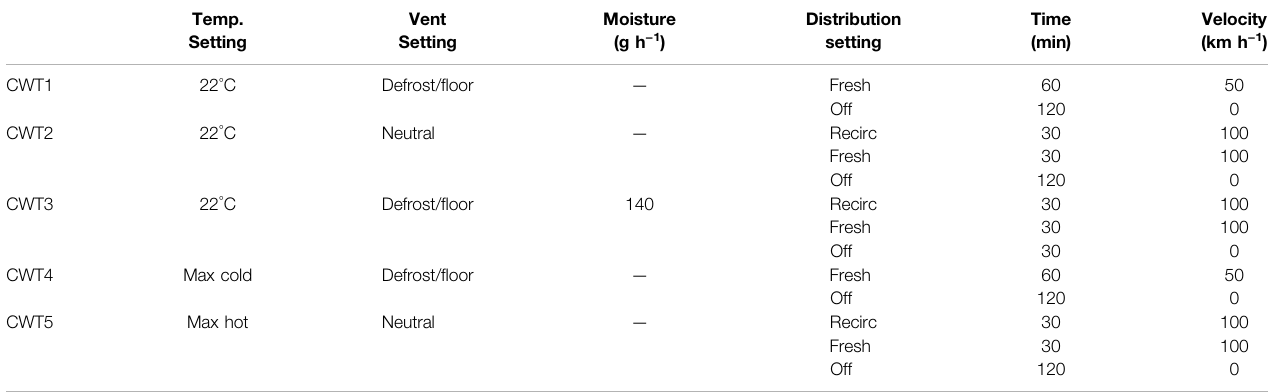
TABLE 1 | Speci fi cation of the CWT test settings.